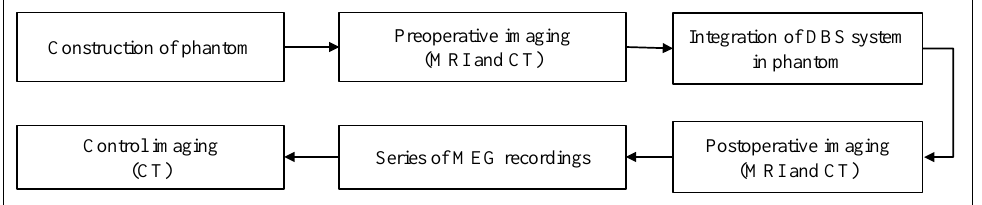
Figure 1. Steps performed to generate imaging and MEG measurement data as part of this study. Preoperative imaging was used to create a 3D model of the phantom. Postoperative imaging was used to determine electrode positions and orientations using a state-of-the-art approach. Localization and orientation detection results from MEG recordings were compared with those from postoperative